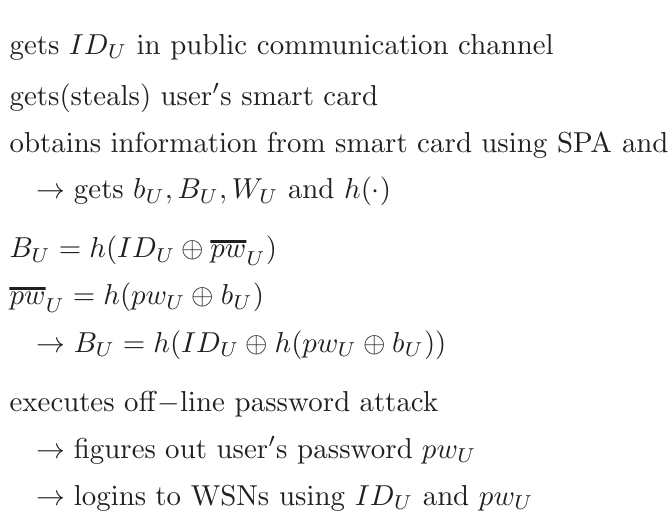
Figure 5. A stolen smart card attack on Shi et al .’s